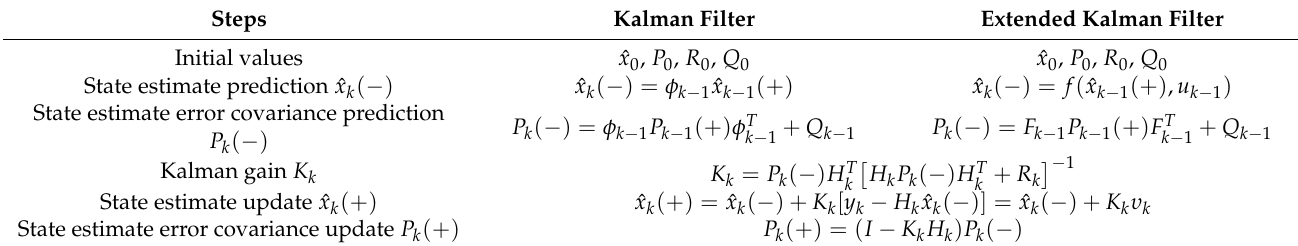
Table 2. Comparison of the Kalman filter and extended Kalman filter